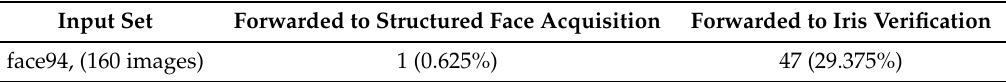
Table 4. Solving rates for impostors, in unsolvable state.